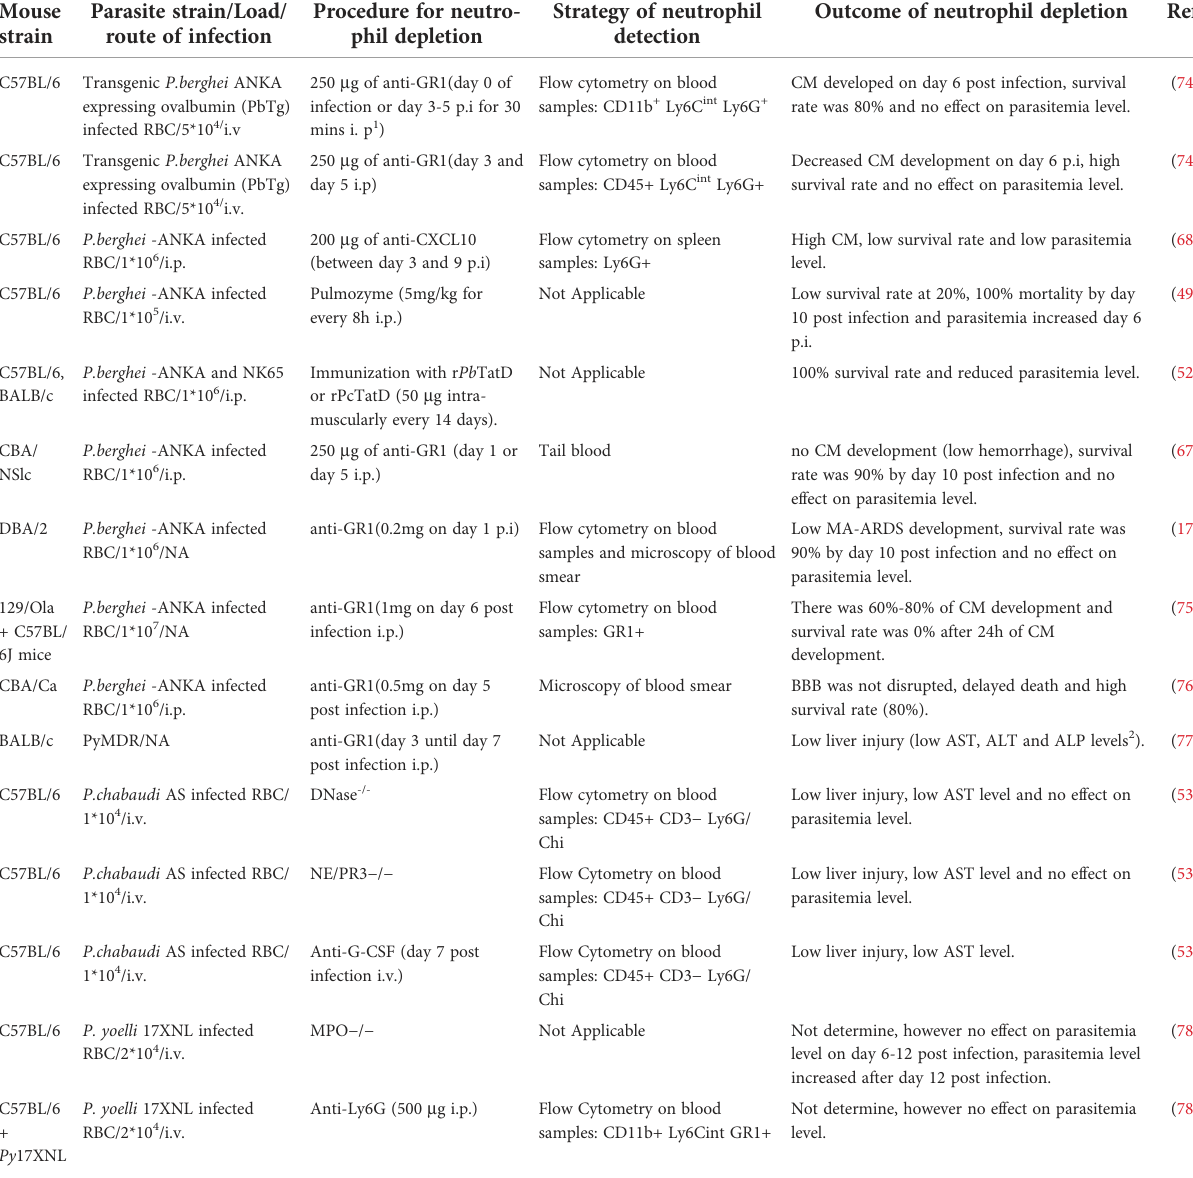
TABLE 1 Showing studies on neutrophil in murine malaria.